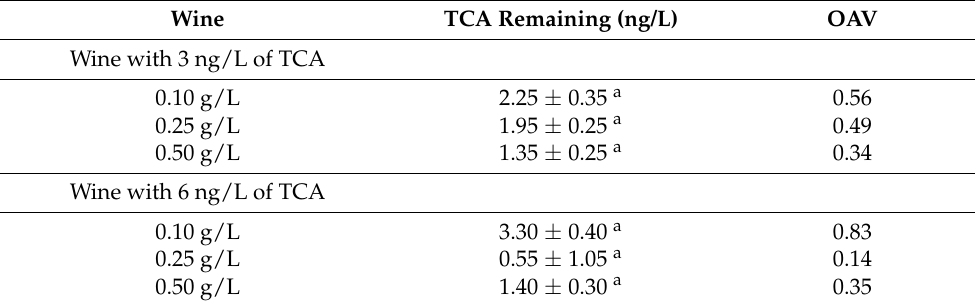
Table 1. TCA remaining in wine contaminated with 3 ng/L of TCA and 6 ng/L of TCA after applying different doses of ADSI cork powder (0.10, 0.25, and 0.50 g/L) and the corresponding TCA odor activity values (OAVs) in the final wines. Wine TCA Remaining (ng/L) OAV Wine with 3 ng/L of